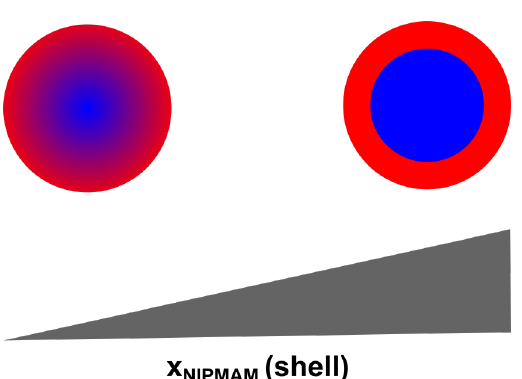
Figure 6. Schematic representation of the structural changes in the core-shell microgels as a function of the PNIPMAM fraction of the shell.